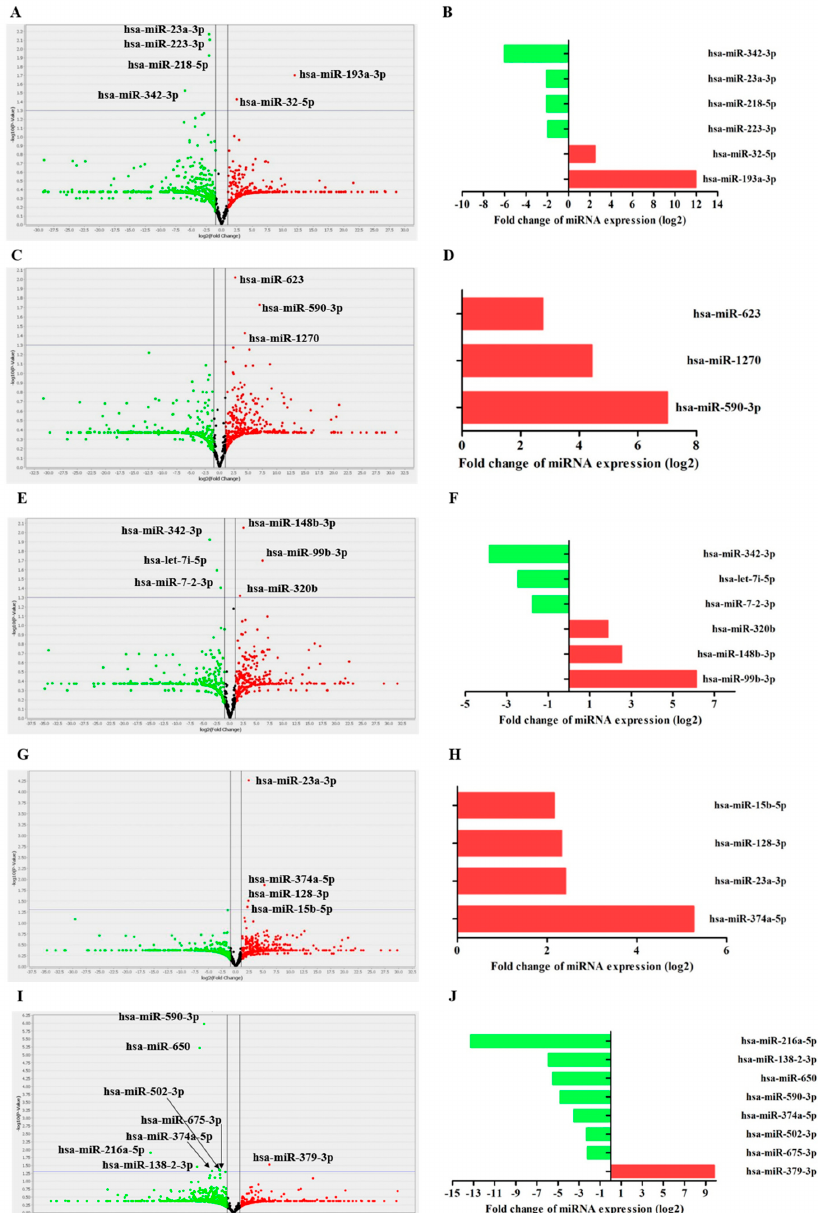
Figure 4. Volcano plot and fold change plot of miRNA regulation detected in THP-1 Mø-like cells infected with H. capsulatum yeasts. Differential analyses were performed between: ( A , B ) THP-1 Mø-like cells infected with the EH-315 strain grown in planktonic form vs. uninfected THP-1 Mø-like cells (control); ( C , D ) THP-1 Mø-like cells infected with the 60I strain grown in planktonic form vs. uninfected THP-1 Mø-like cells (control); ( E , F ) THP-1 Mø-like cells infected with the EH-315 strain grown in biofilm form vs. uninfected THP-1 Mø-like cells (control); ( G , H ) THP-1 Mø-like cells infected with the EH-315 strain grown in biofilm form vs. THP-1 Mø-like cells infected with the EH-315 strain grown in planktonic form; and ( I , J ) THP-1 Mø-like cells infected with the EH-315 strain vs. THP-1 Mø-like cells infected with the 60I strain, both grown in planktonic form. In the volcano plot, the x-axis shows the relative quantification (RQ) of each miRNA expression between each tested sample and its respective control in a log2 scale, while the y-axis shows the p- value for each miRNA adjusted in a log10 scale. Dots above the horizontal grey line indicate statistical significance ( p ≤ 0.05). Spots in green indicate downregulated miRNAs and spots in red indicate upregulated miRNAs. The fold change plot shows RQ values of miRNAs expressed in the described samples and analyzed with the DataAssist version 3.01 software using the comparative method of Cq ( ∆∆ Cq). Twenty-seven miRNAs exhibited significant differential expression ( p ≤